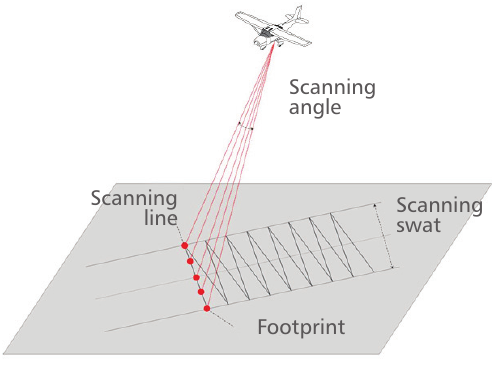
FIGURE 1. An illustration of the basic scanning attributes of the ALS data acquisition